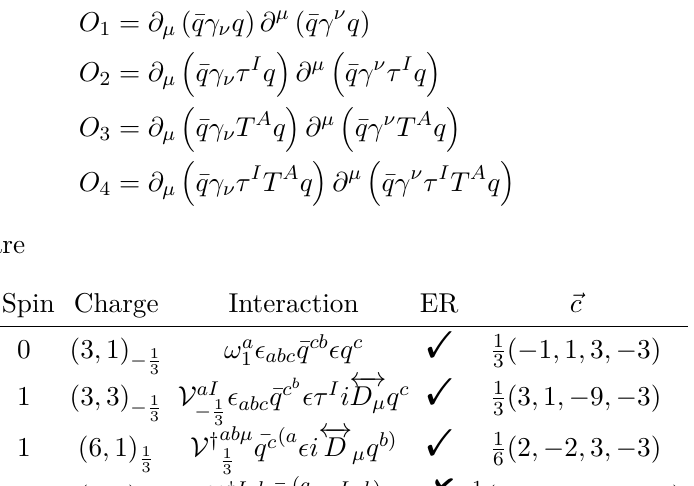
Figure 14. The dim-6 space region (blue and green) is outside of H blue region corresponds to c